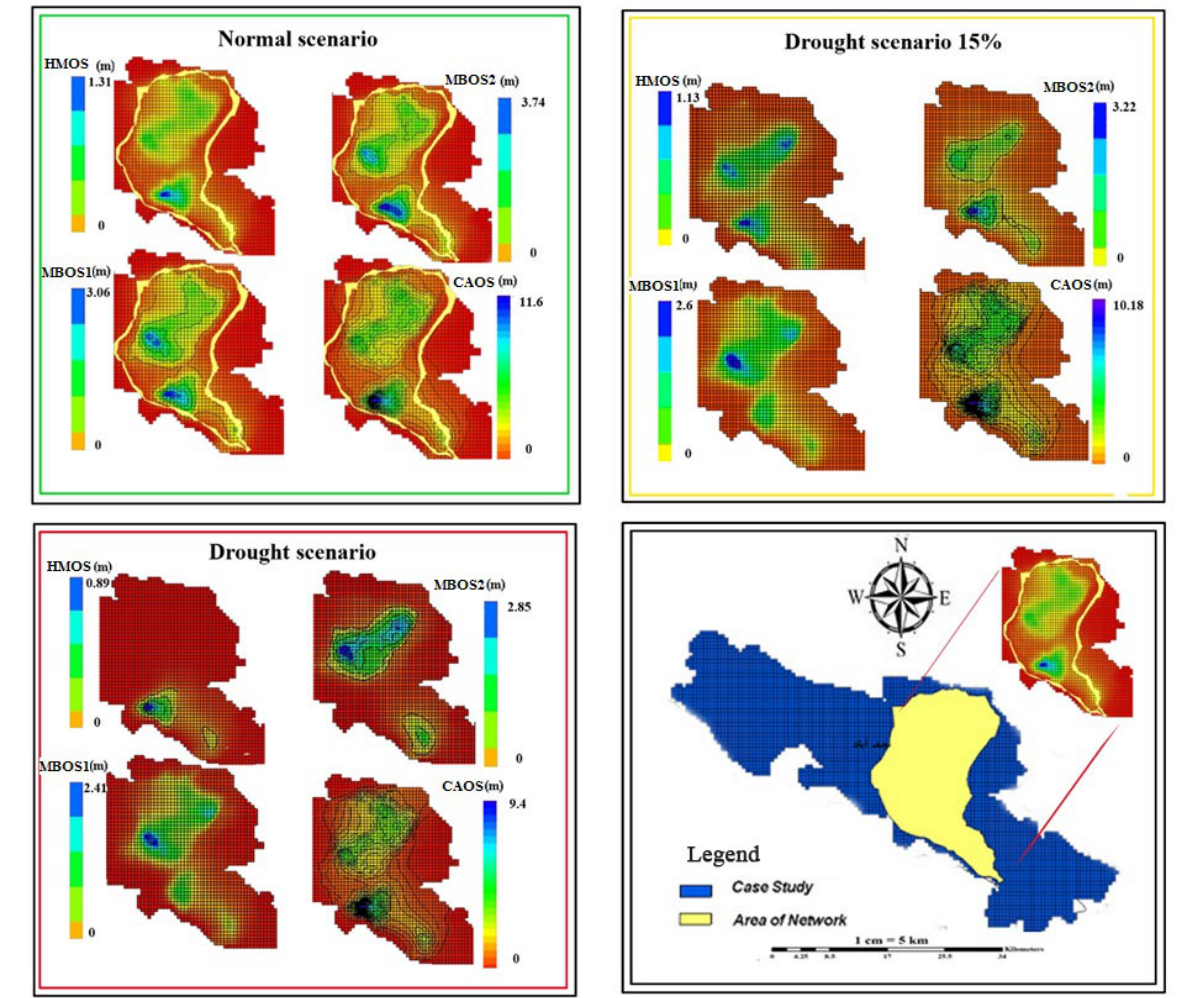
Figure 7. Groundwater level rise under the influence of balancing strategies in normal and drought scenarios (15 and 30%).